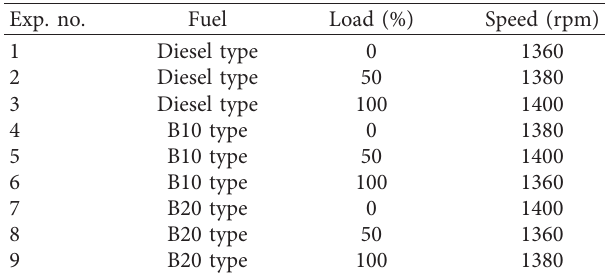
Table 4: Orthogonal array design of experiment. Exp.